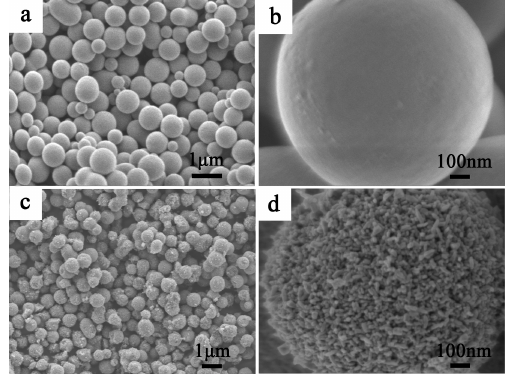
Figure 3. SEM of precursor beads ( a , b ) and mesoporous spherical TiO 2 obtained after hydrothermal and calcination treatment ( c , d ).